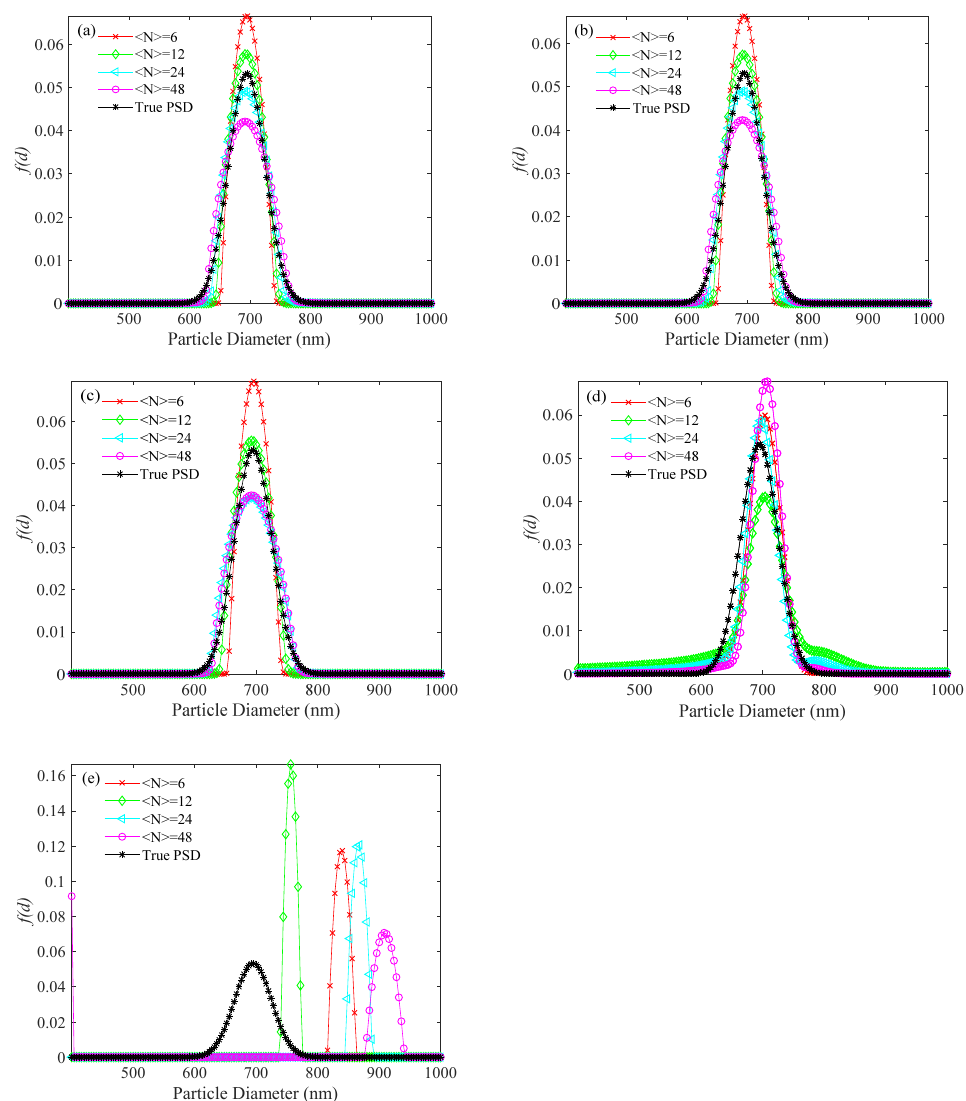
Figure 7. PSD recovered by the usual method for a 696 nm unimodal sample at number concentrations of < N > = 6, 12, 24, 48, and different levels of noise. ( a ) 0, ( b ) 10 − 4 , ( c ) 10 − 3 , ( d ) 10 − 2 , and ( e ) 10 − 1 noise levels.